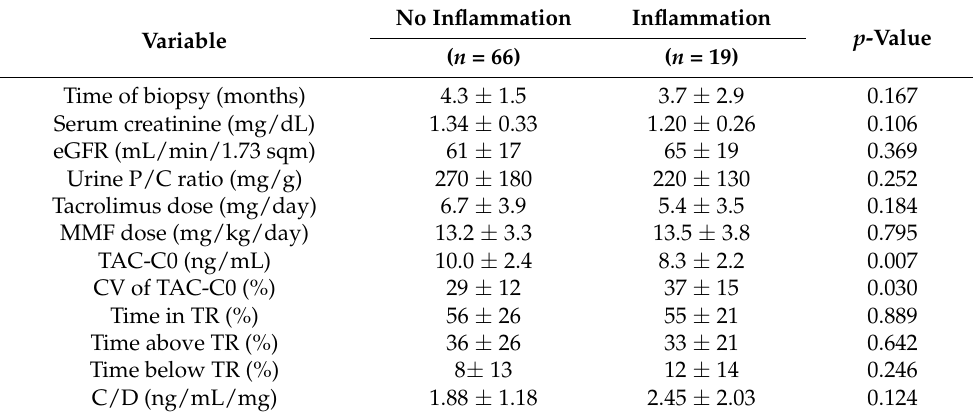
Table 4. Clinical and therapeutic drug monitoring data in patients with (i-score ≥ 1) and without (i-score = 0) interstitial inflammation in the first surveillance